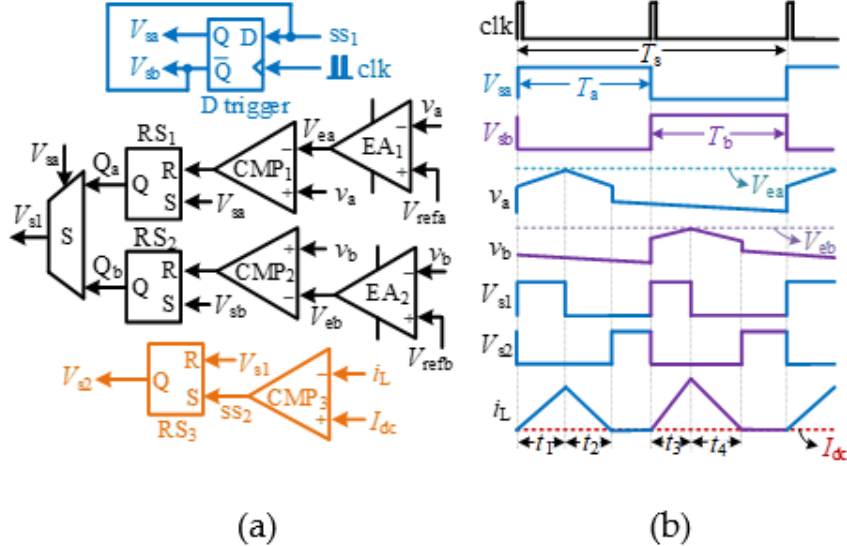
Figure 3. Voltage ripple-controlled PCCM SIDO buck converter: ( a ) control block diagram; ( b ) operation waveforms.